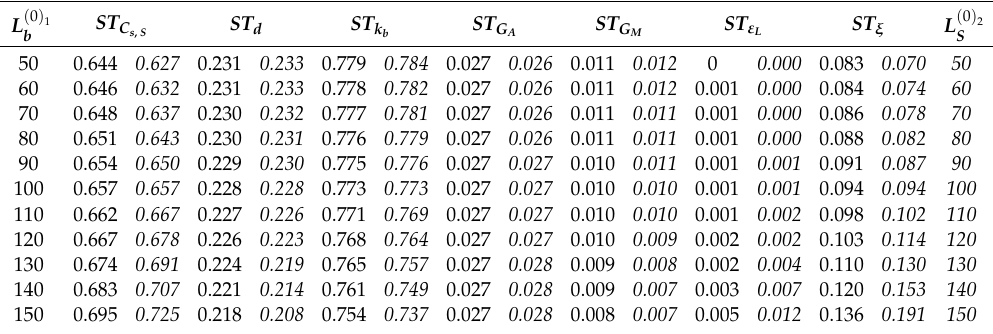
Table 4. Total Sobol indices ( ST ) of δ S ( L = 300): Case 1 (left) and Case 2